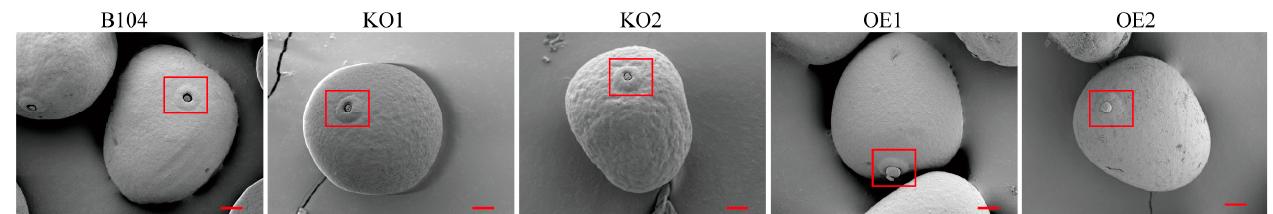
Figure 3. Representative SEM micrographs of pollen grains from WT and transgenic plants. The view highlights the aperture (inside the red box) of a pollen grain, showing the presence of a convex operculum covering the pore of OE pollen grain. Scale bar: 10 µm.